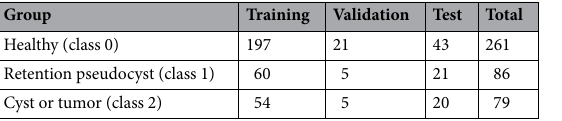
Table 1. Number of maxillary sinuses in the training, validation, and test